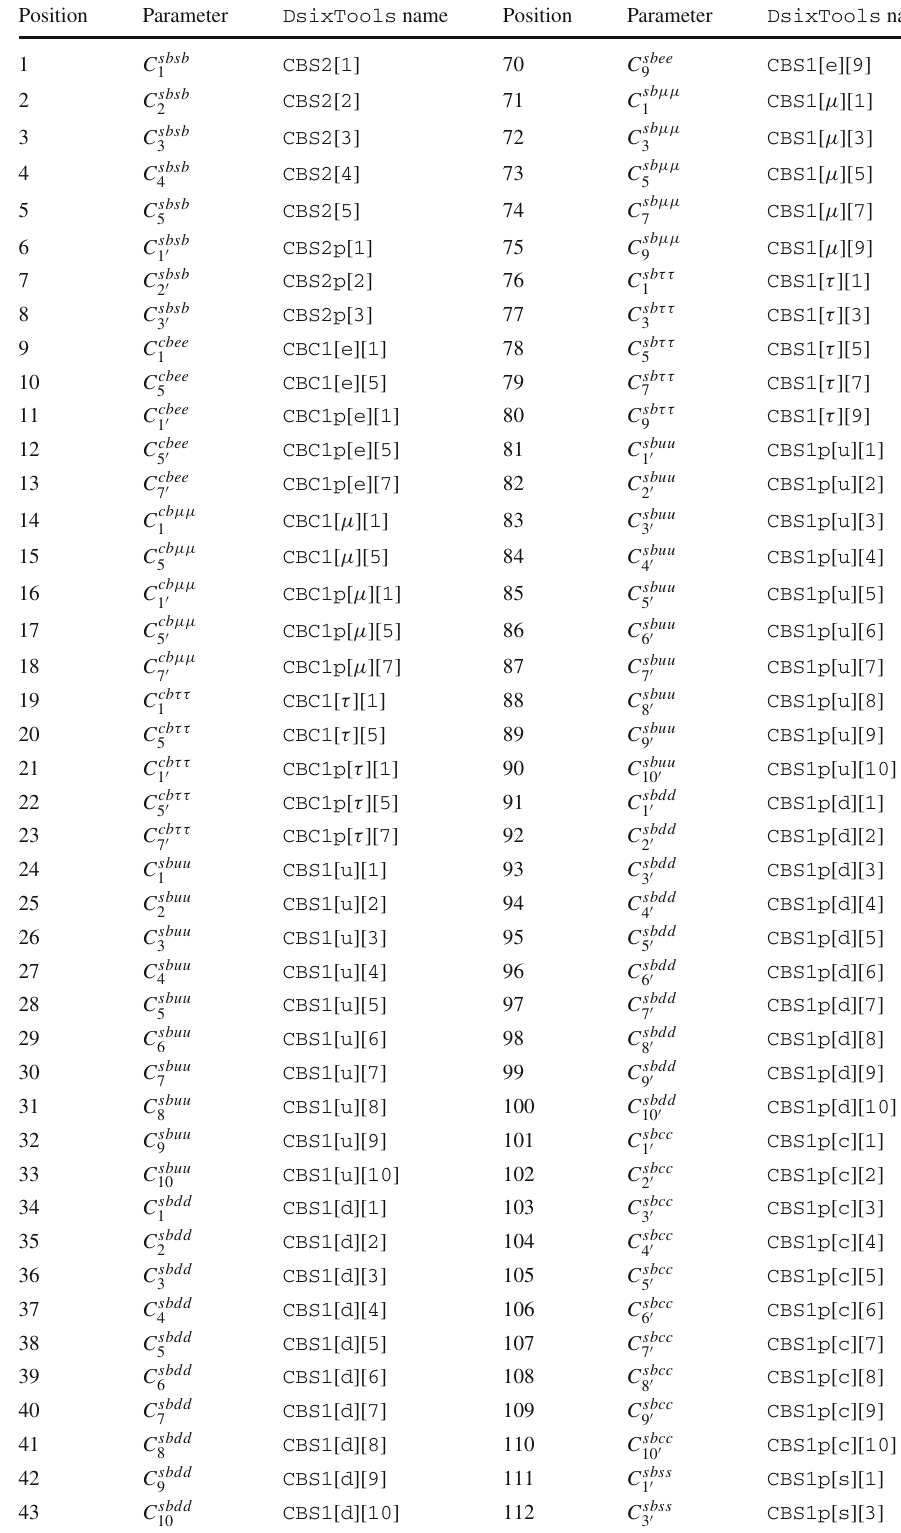
Table 8 WET parameters. Position denotes the position of the parameter in the WETParameters global